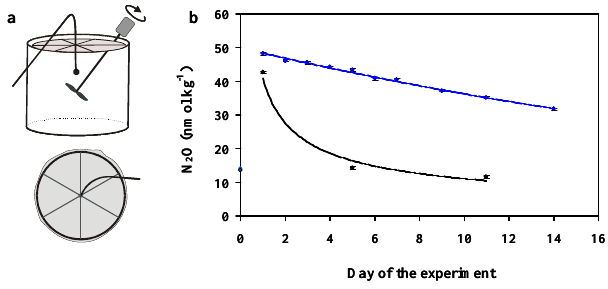
Fig. 8. (a) Schematic drawing of the Kiel indoor mesocosm. With stirrer, floating lid and sampling hose, below: vertical view on float- ing foil lid with enforcement frame. (b) Comparison of N 2 O tracer outgassing in a Kiel indoor mesocosm, between a simple uncovered setup (black) and a setup using a floating foil lid reducing the water surface area available for air–sea gas exchange